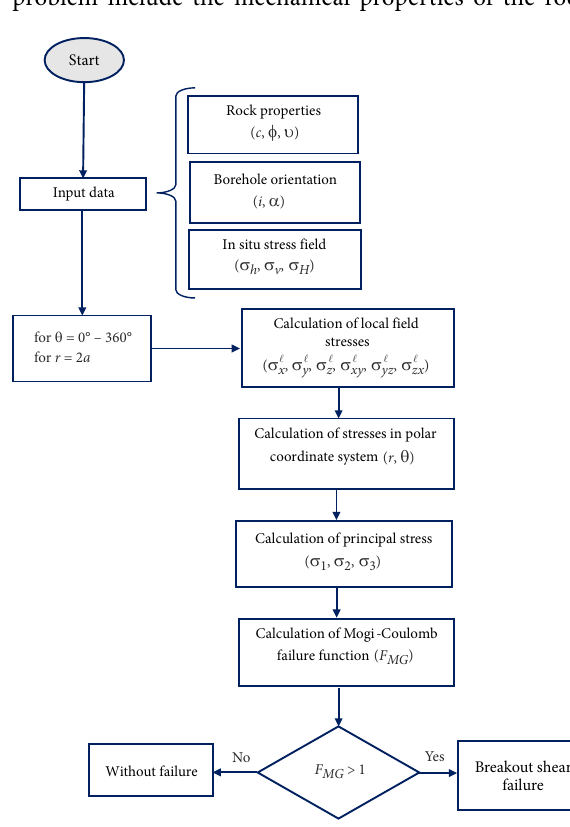
Figure 5. Calculation